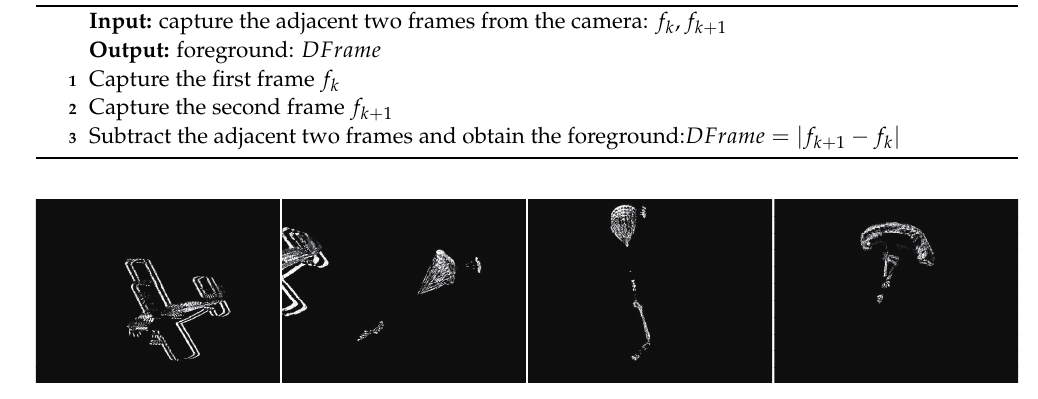
Figure 8. Foreground segmentation.